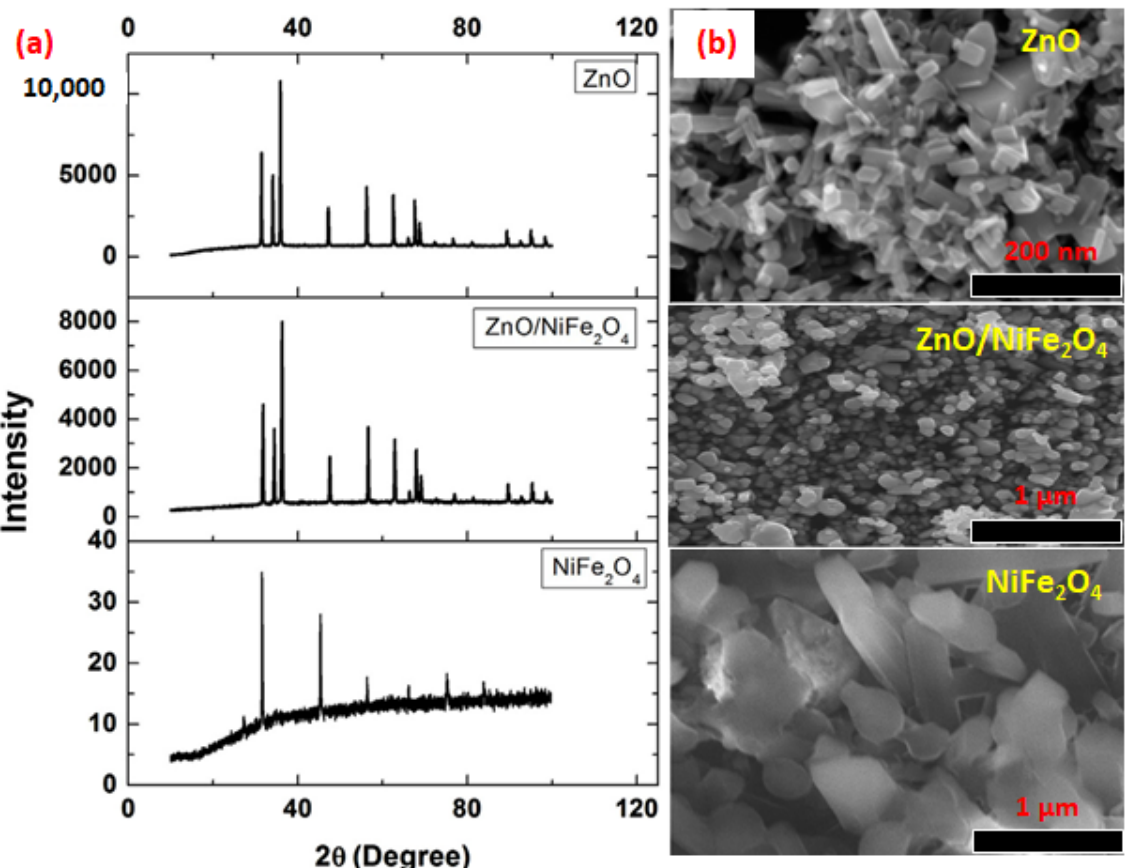
Figure 5. ( a ) XRD structural and ( b ) SEM micrographs of ZnO, NiFe 2 O 4, and magnetic ZnO/NiFe 2 O 4 nanocomposites [76]. Republished with permission from Elsevier.